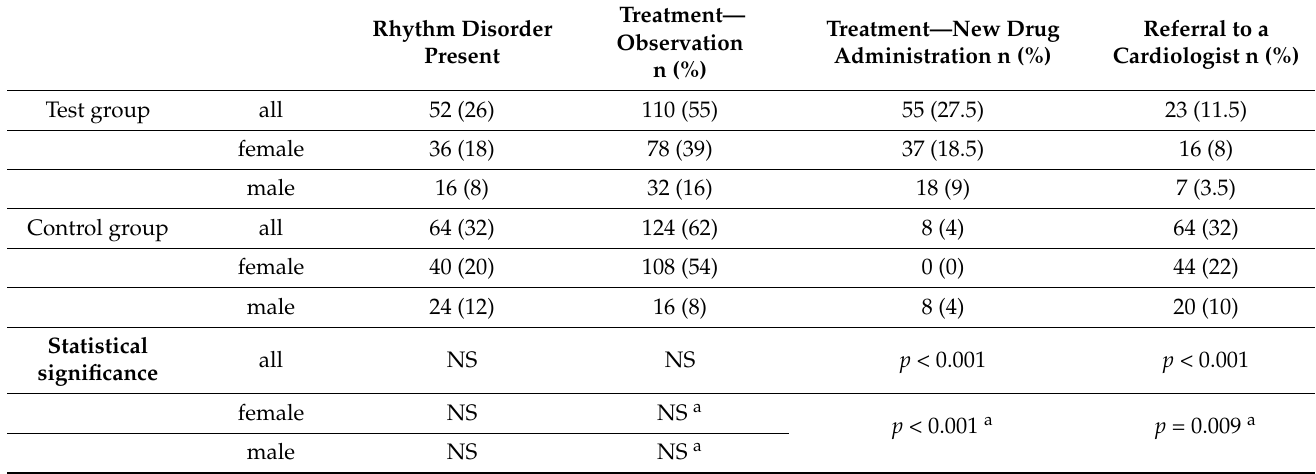
Table 4. Actions taken after receiving the electrocardiogram (ECG) sensor report for patients in the test and control groups.